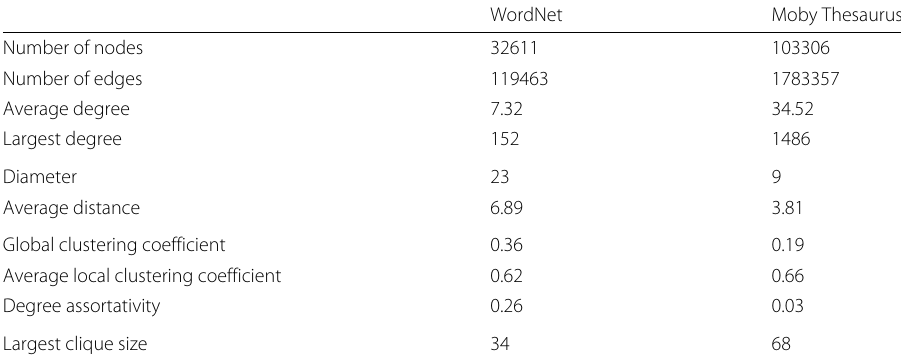
Table 1 Basic characteristics of the largest connected component of WordNet synonyms and Moby Thesaurus